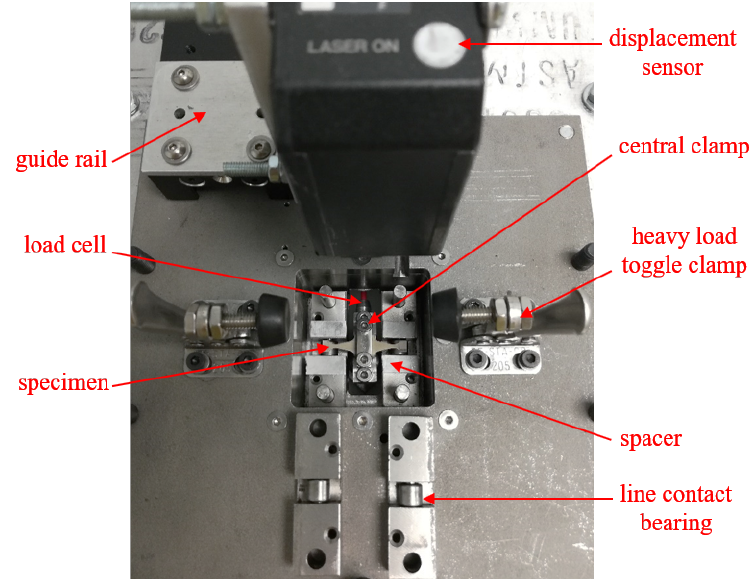
Figure 7. Fatigue test bench setup